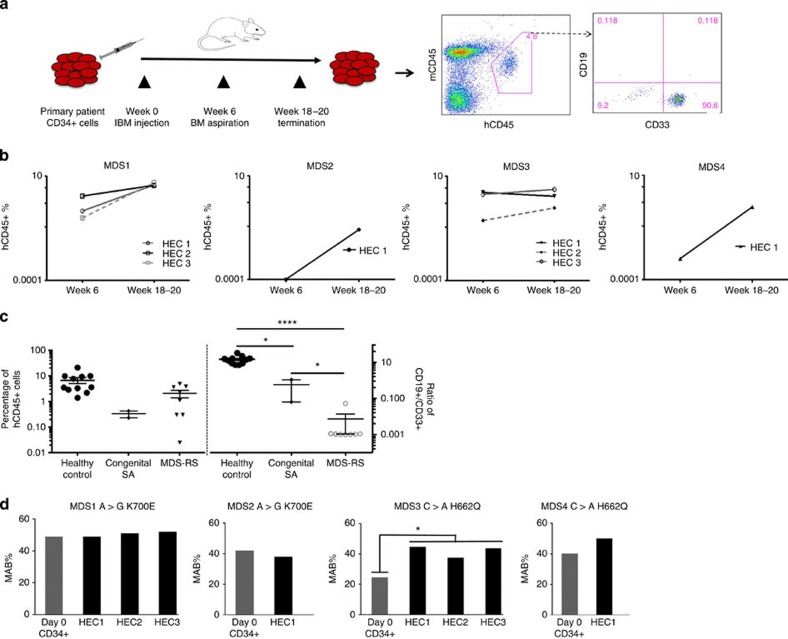
Engraftment and genotype of human RARS-originated and control haematopoietic cells in the bone marrow of NOD/SCID/IL2rγ−/− mice.(a) Schematic representation of the xenograft model. Right-hand side panel shows the flow cytometry profile of bone marrow cells recovered from one human-cell-engrafted mice. The majority of human CD45-expressing cells were positive for a myeloid marker CD33+ in all analysed cases in this study. (b) Percentage of human CD45+ cells in the bone marrow of NSG mice at 6 and 18–20 weeks after transplantation (MDS1, n=3; MDS2, n=1; MDS3, n=3 and MDS4, n=1). (c) Percentages of human haematopoietic cells and ratio of CD19+/CD33+ isolated from the bone marrow of mice engrafted with either MDS-RS (n=4 patients and transplanted in a total eight mice) or healthy controls CD34+ cells (n=3 healthy donors and transplanted in a total of 11 mice) or congenital sideroblastic anaemia patient (n=1 patient transplanted in two mice). The y axis (left) represents the percentage of the human CD45+ cells present in the total mouse bone marrow. The y axis (right) represents the ratio of the human CD19+ versus human CD33+ cells within the human CD45+ cells recovered following xenotransplant. MDS xenografts showed a significant skewing towards myeloid lineage. *P<0.05, ****P<0.0001 (t-test). (d) Targeted mutational analysis shows the presence of concordant SF3B1 mutations in primary CD34+ bone marrow sample (grey) and xenograft (black) in all analysed cases. Three independent PCR/sequencing experiments were performed to confirm/determine the mutant allele burden throughout the experiments. The sequencing coverage across the SF3B1 amplicons was ≥1,000 reads. *P<0.01 (t-test).